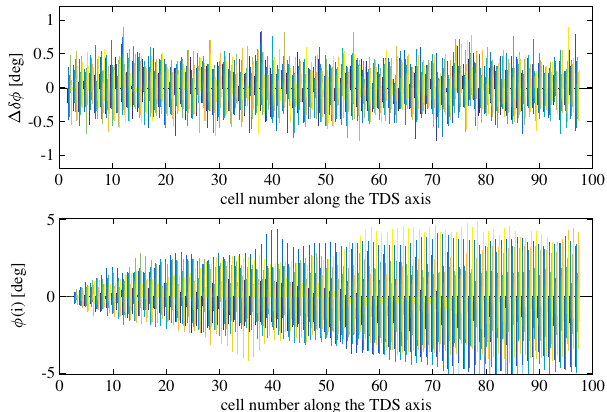
FIG. 14. 50 configurations of machining errors for the pro- duction of the TDS cups having random cell-to-cell phase advance